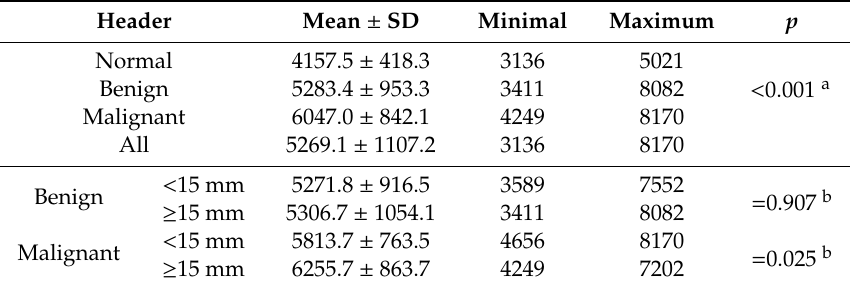
Table 3. Distribution of anomaly score.